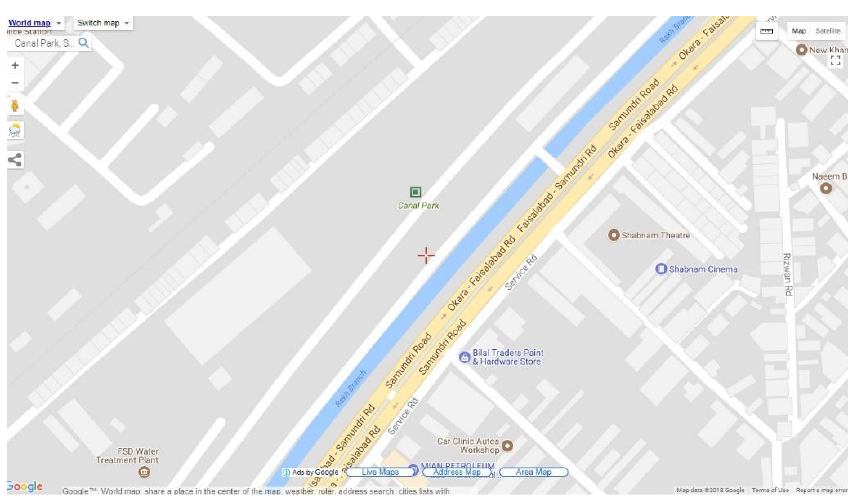
Figure 2: Geographical position of Canal Park, Samundri Road 98 ft away from main road